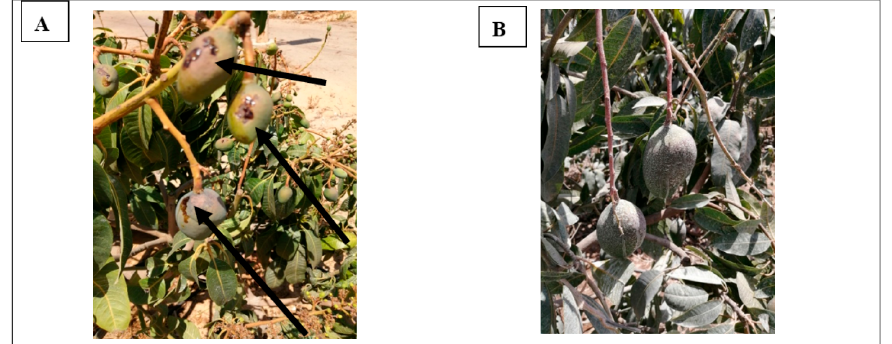
Figure 10. ( A ) Sunburned fruits disorder arrowed (control) and ( B ) Keitt mango tree fruits after kaolin foliar spray in June.